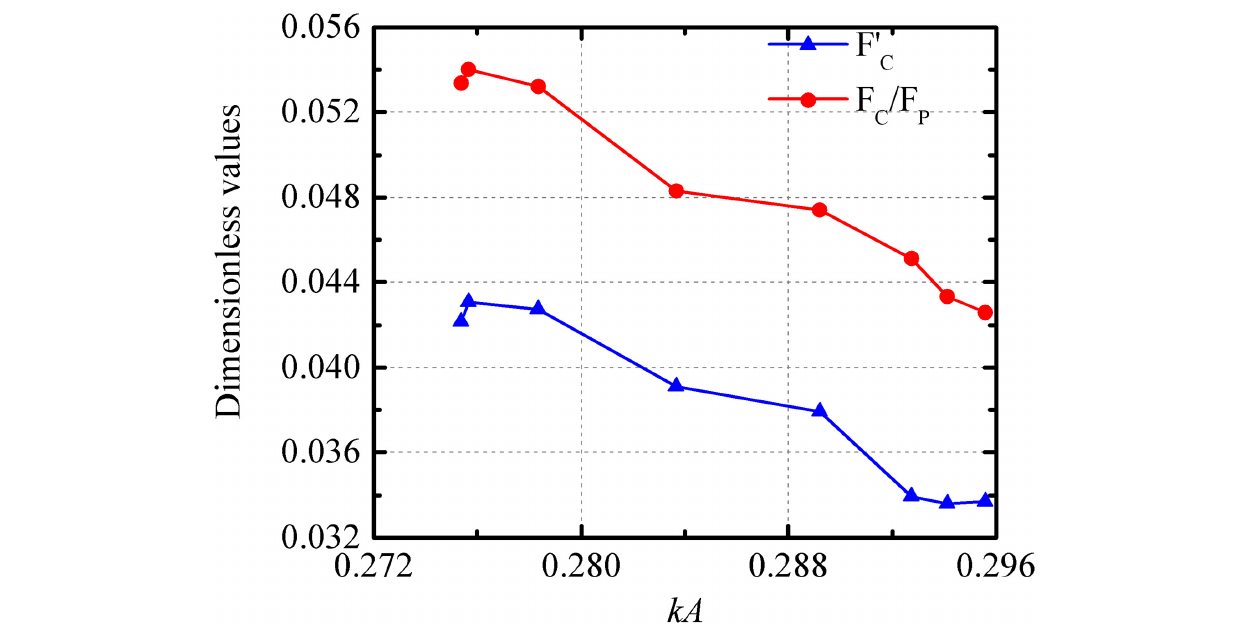
FIGURE 11 | The relationship between F (cid:48) c , F c / F p , and